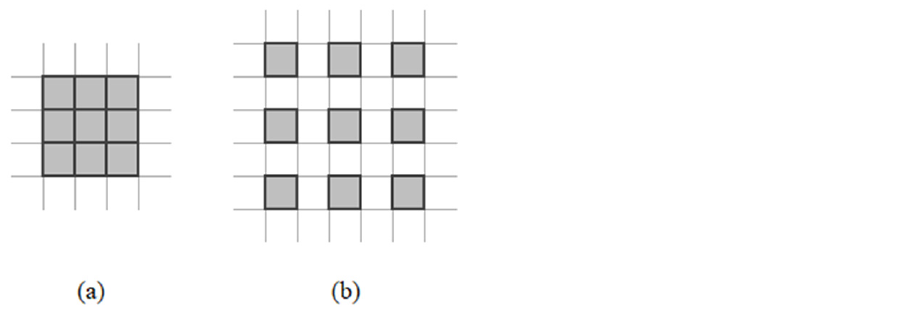
Figure 2. A schematic diagram of the atrous convolution at different expansion rates. ( a ) r = 1; ( b ) r = 2.